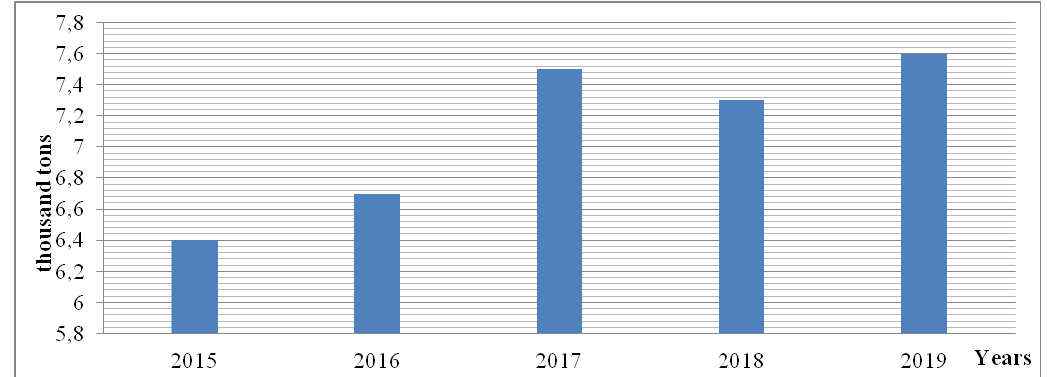
In tern in 2014 the export also decreased by 23 % com- pared to 2013 and amounted to 39.6 thousand tons for a total of $ 48.6 million, while in 2013 it was 51.4 thousand tons for a total of $ 65.1 million.